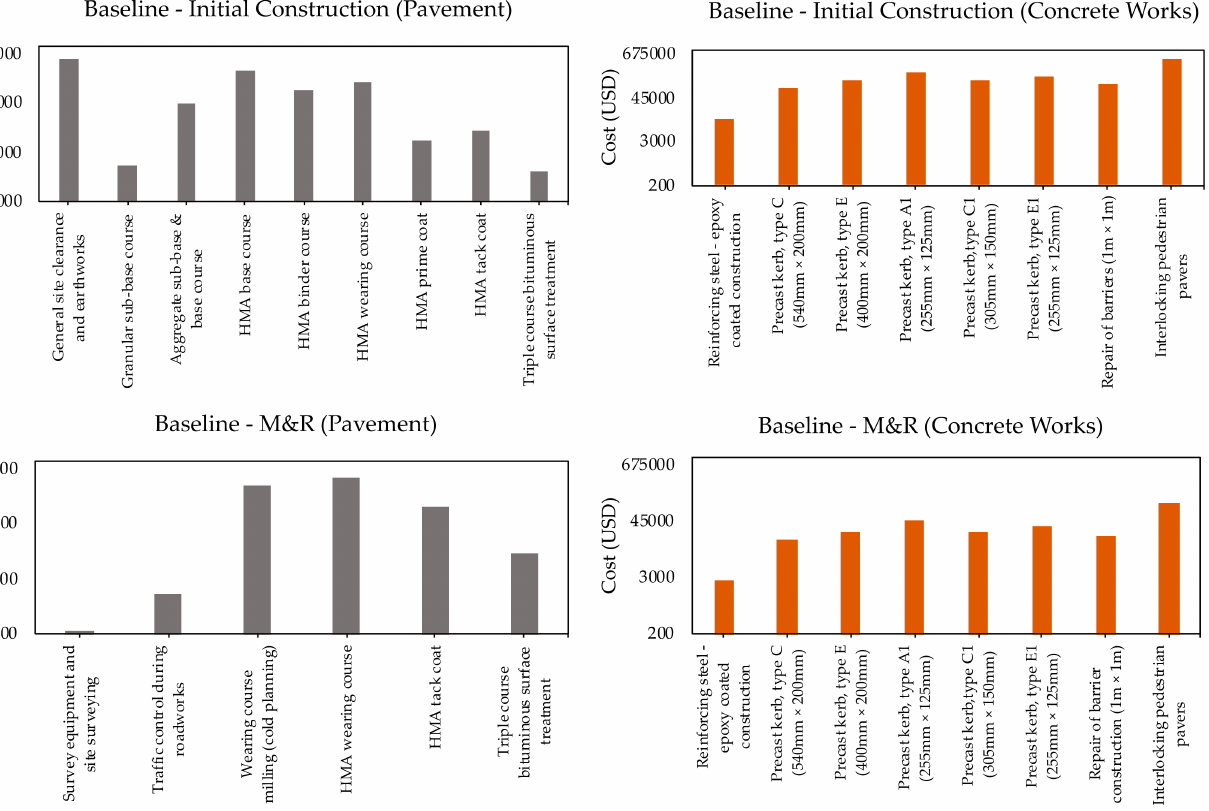
Figure 3. LCCA results for the studied road in the baseline scenario using virgin materials for included lifecycle